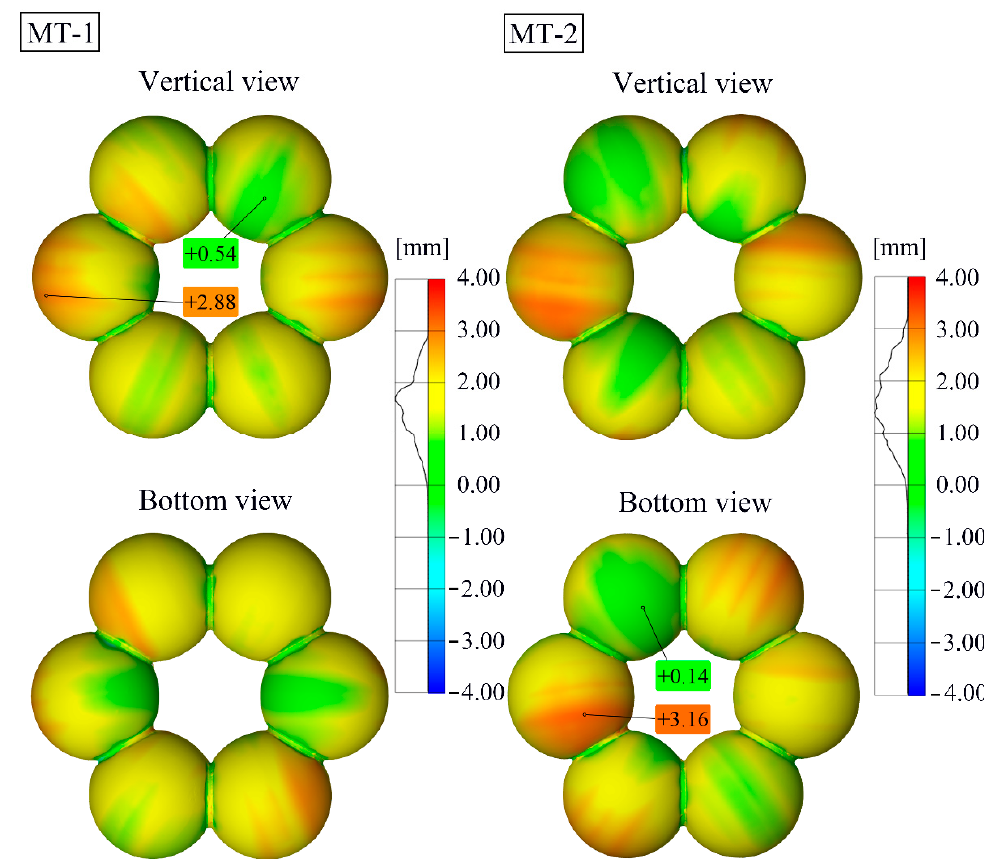
Figure 4. Geometric deviation between the scanned models and perfect geometries of two laboratory models sphere-segmented toroidal shells (named ST-1 and ST-2, respectively).